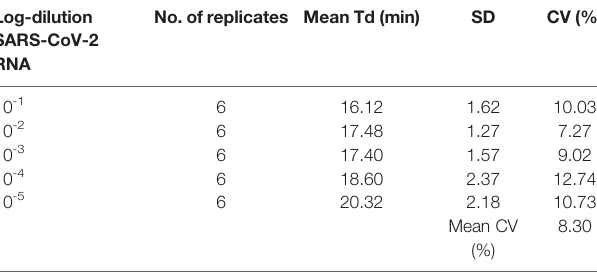
TABLE 3 | Inter-assay precision of the multiplex RT-LAMP